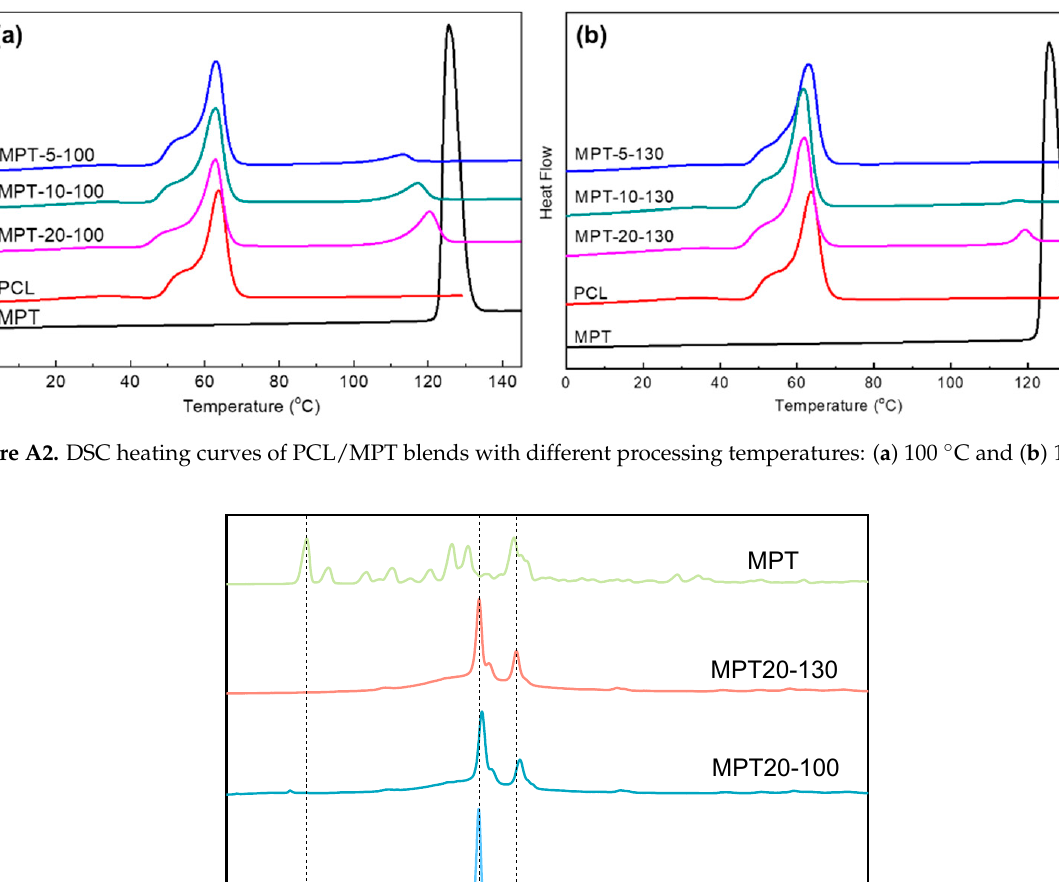
Figure A3. WAXD patterns for PCL/MPT-80/20 at different processing temperatures.